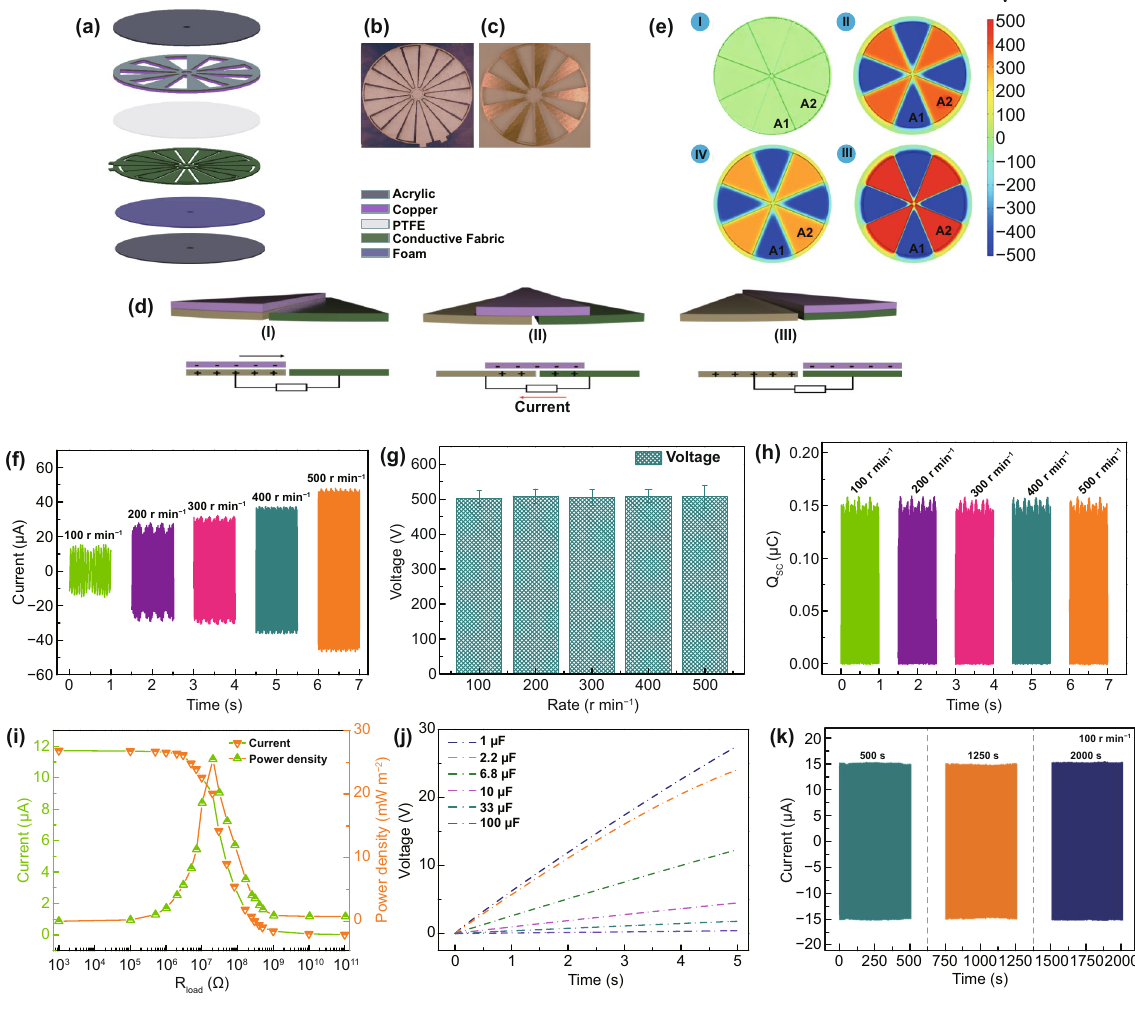
Fig. 1 Schematic diagram. a A schematic illustration of the functional components of multifunctional TENG. A photograph of b stator and c rotator. The working principles of TENG with the freestanding module: d schematic working principle of TENG (I–III) and e the simulated potential distributions for TENG at three different rolling displacements by COMSOL software. Performance of TENG. f Short-circuit current, g open-circuit Voltage, h short-circuit charge quantity of TENG at different rotation rates. i Capacitor charging ability of the TENG under 100 r min −1 . j Current and peak power of the TENG measured with different external load resistances under 100 r min −1 . k Stability of open-circuit voltage over 16,000